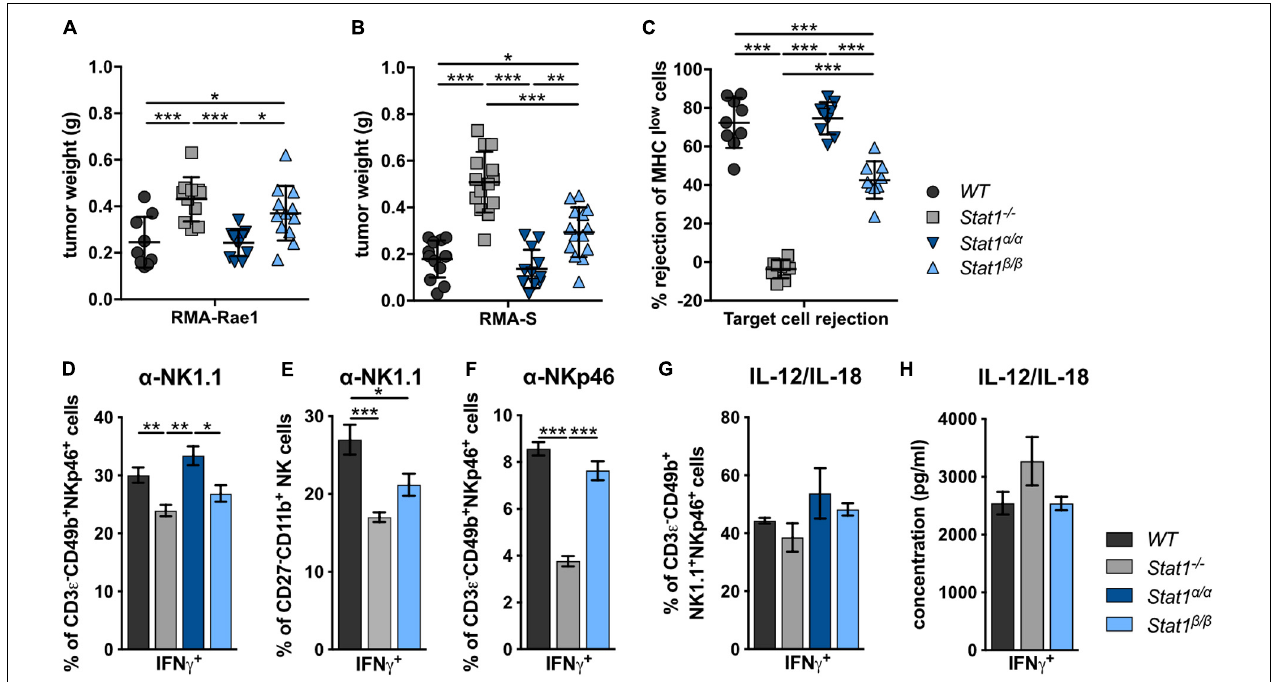
FIGURE 3 | Stat1 β / β , but not Stat1 α / α , mice show reduced NK cell-dependent anti-tumor activity, in vivo cytotoxicity and impaired production of IFN γ in response to actR stimulation. (A,B) 1 × 10 6 RMA-Rae1 (A) or RMA-S (B) cells were s.c. injected in both flanks of WT , Stat1 − / − , Stat1 α / α , and Stat1 β / β mice. Ten days after injection the tumors were isolated and weighed. Tumor weight ( n = 9–14) and mean values ± SD from two experiments are shown. (C) WT , Stat1 − / − , Stat1 α / α , and Stat1 β / β mice were i.v. injected with a 1:1 mix of CFSE low stained WT and CFSE high stained MHC I low ( β 2m − / − ) splenocytes. The ratio of CFSE low and CFSE high cells in the spleen of recipient mice was determined 16 h after injection by flow cytometry. Mean percentages ± SD ( n = 9) from three experiments are given. (D–F) Splenocytes from WT , Stat1 − / − , Stat1 α / α , and Stat1 β / β mice were stimulated with tube-bound anti-NK1.1 antibody (D,E) , tube-bound anti-NKp46 antibody (F) and IL-12 (5 ng/ml) and IL-18 (25 ng/ml) (G) , and incubated in the presence of brefeldin A. IFN γ production was analyzed by intracellular staining of NK cells (D,F,G) or M2 mature NK cells (CD27 − CD11b + ) (E) . Mean percentages ± SEM from six ( n = 6–18) (D) , three experiments ( n = 9) (E) , one experiment ( n = 3) (F) , and two experiments ( n = 5–6) (G) are shown. (H) Magnetic beads-purified NK cells were stimulated with IL-12 (5 ng/ml) and IL-18 (25 ng/ml) for 6 h. IFN γ was determined in the culture supernatant by ELISA. Mean IFN γ concentrations ± SEM from one experiment ( n = 3) is depicted. * p < 0.05; ** p < 0.01; *** p <